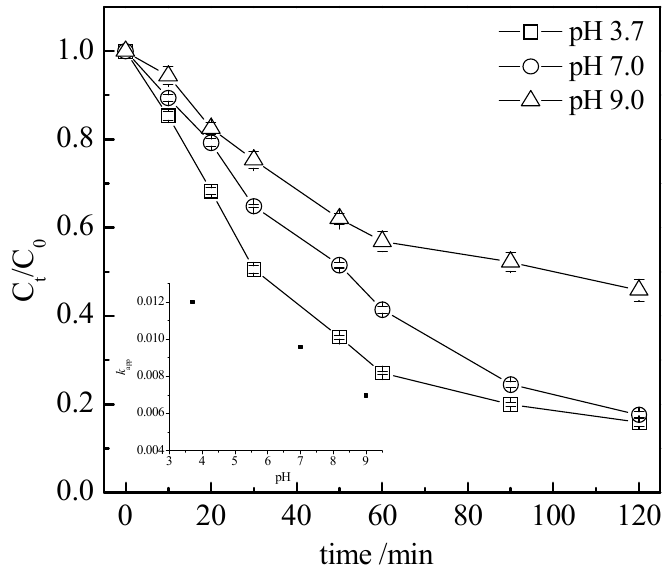
Figure 8. Effect of reaction medium initial pH on the tetracycline degradation. Conditions: Figure 8. E ff ect of reaction medium initial pH on the tetracycline degradation. Conditions: C 0 = 100 C 0 = 100 mg L − 1 , [BA] = 0.5 g L − 1 , and [PS] = 50 mmol L − 1 mg L − 1 , [BA] = 0.5 g L − 1 , and [PS] = 50 mmol L − 1 . When compared to the value obtained at pH = 3.5 ( k app = 0.012 min − 1 ), the value of the